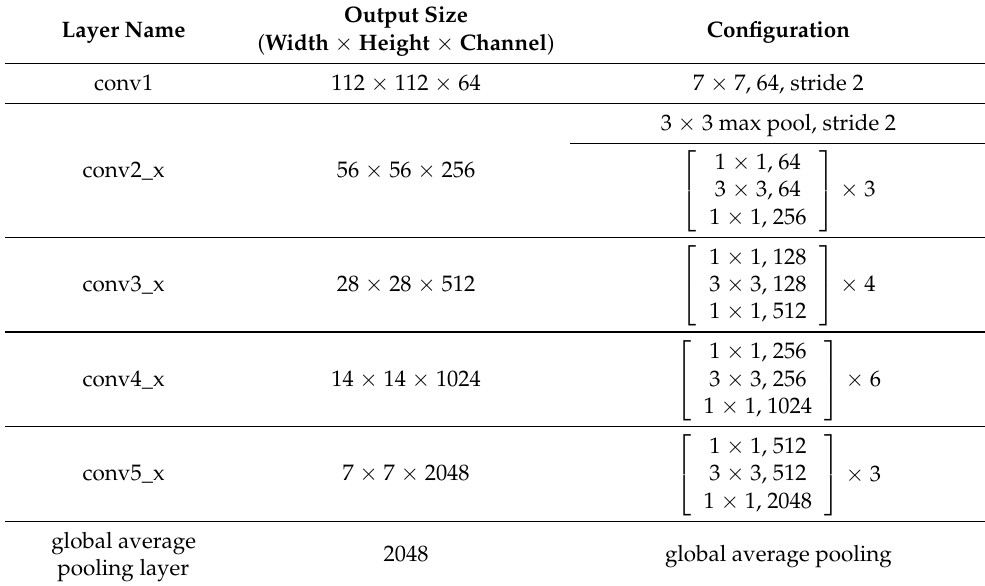
Table 1. The Architecture for the